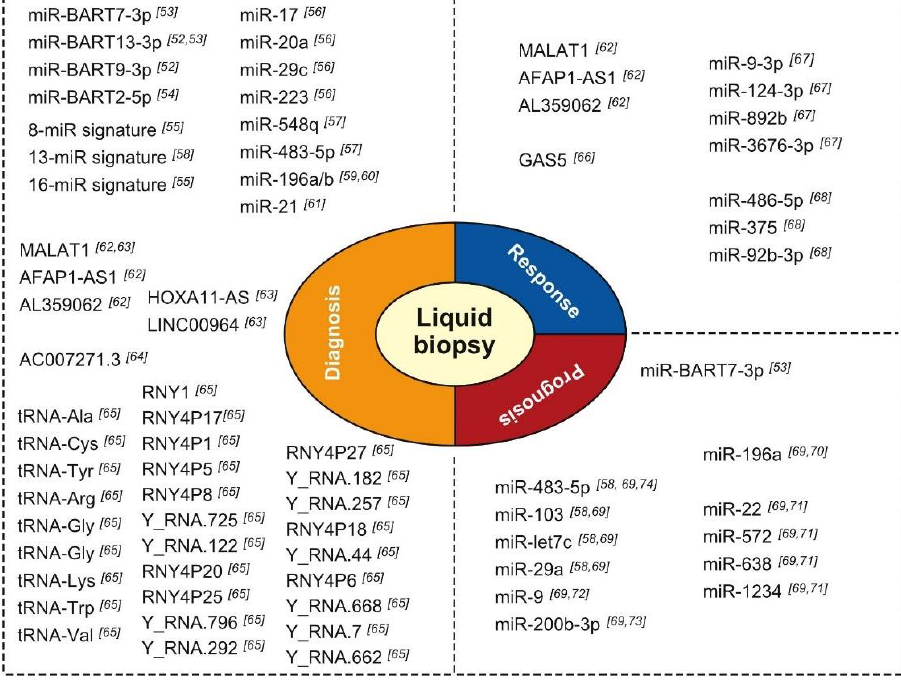
Figure 3. Condensed overview of circulating non-coding RNAs with purported diagnostic, prognostic, or treatment response prediction value in HNC [51–73].